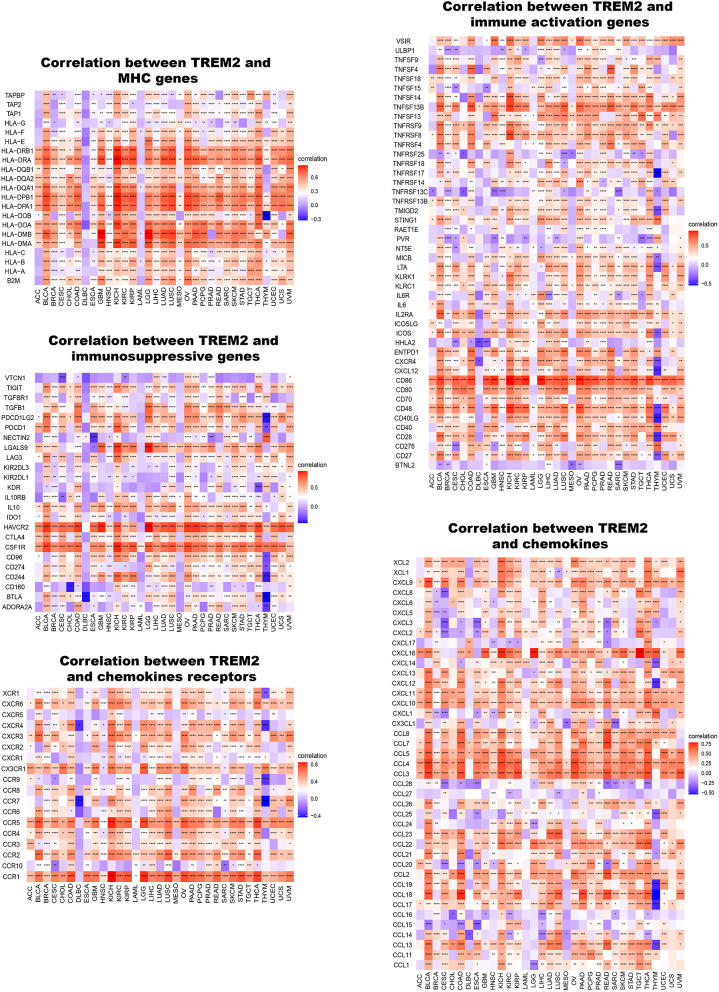
Co-expression of TREM2 and immune-related genes. *P < 0.05, **P < 0.01, ***P < 0.001, ****P < 0.0001.